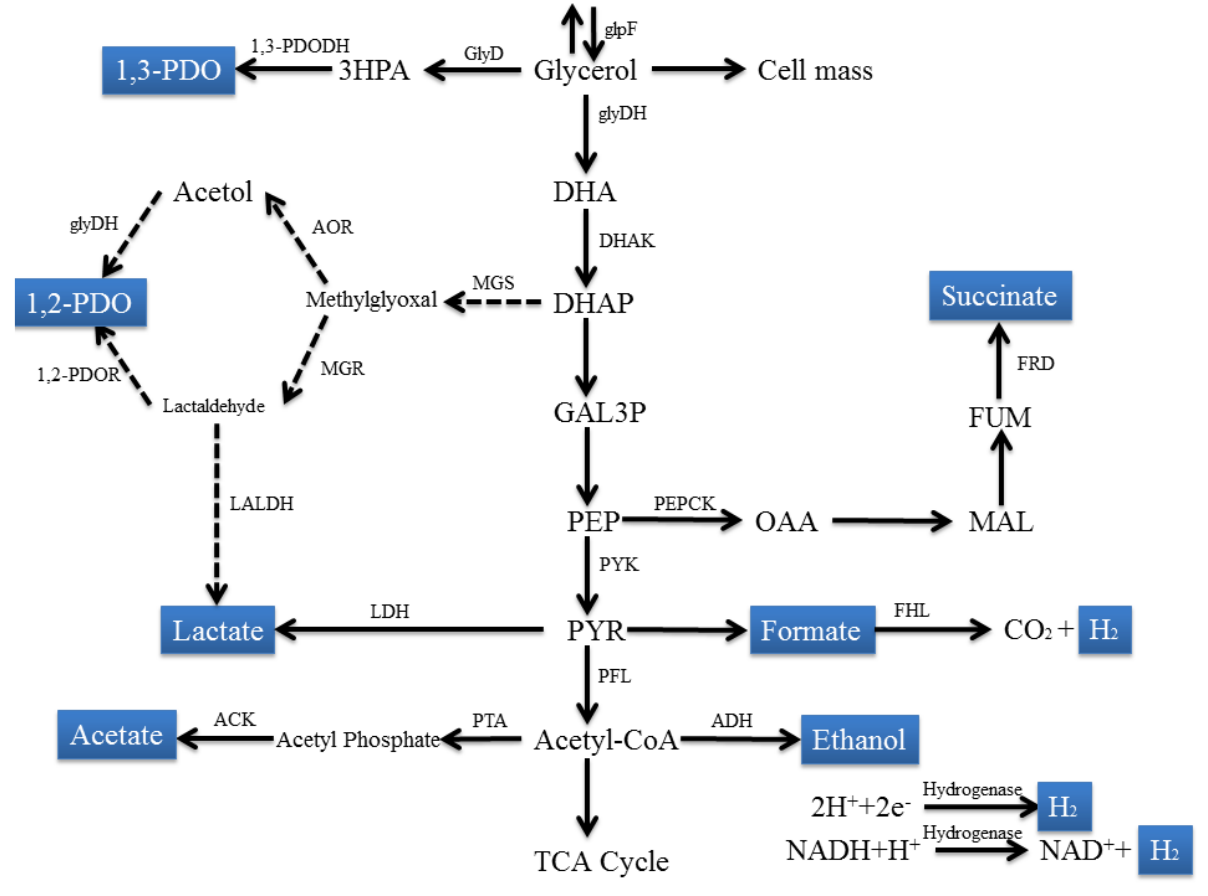
Figure 2. Prokaryotic pathway of glycerol utilization in Entrerobacteriaceae species (adapted from [4,17]). Enzymes: ACK, acetate kinase; ADH, acetaldehyde/alcohol dehydrogenase; AOR, aldehyde oxidoreductase; DHAK, dihydroxyacetone kinase; FHL, formate hydrogen lyase complex; FRD, fumarate reductase; GlyD, glycerol dehydratase; glyDH, glycerol dehydrogenase; glpF, glycerol transporter, LALDH, lactaldehyde dehydrogenase; LDH, lactate dehydrogenase; MGR, methylglyoxal reductase; MGS, methylglyoxal synthase; PFL, pyruvate formate-lyase; PEPCK, phosphoenolpyruvate carboxykinase; PTA, phosphate acetyltransferase; PYK, pyruvate kinase; 1,2-PDOR, 1,2-propanediol reductase; 1,3-PDODH, 1,3-propanediol dehydrogenase. Chemical intermediates and products: DHA, dihydroxyacetone; DHAP, dihydroxyacetone phosphate; FUM, fumarate; GAL3P, glyceraldehyde-3-phosphate; 3HPA, 3-hydroxypropionaldehyde; MAL, malate; OAA, oxaloacetate; PEP, phosphoenolpyruvate; PYR, pyruvate; 1,2-PDO, 1,2-propanediol; 1,3-PDO, 1,3-propanediol. (Dash line indicates reactions for 1,2-PDO pathway; filled box indicates potential